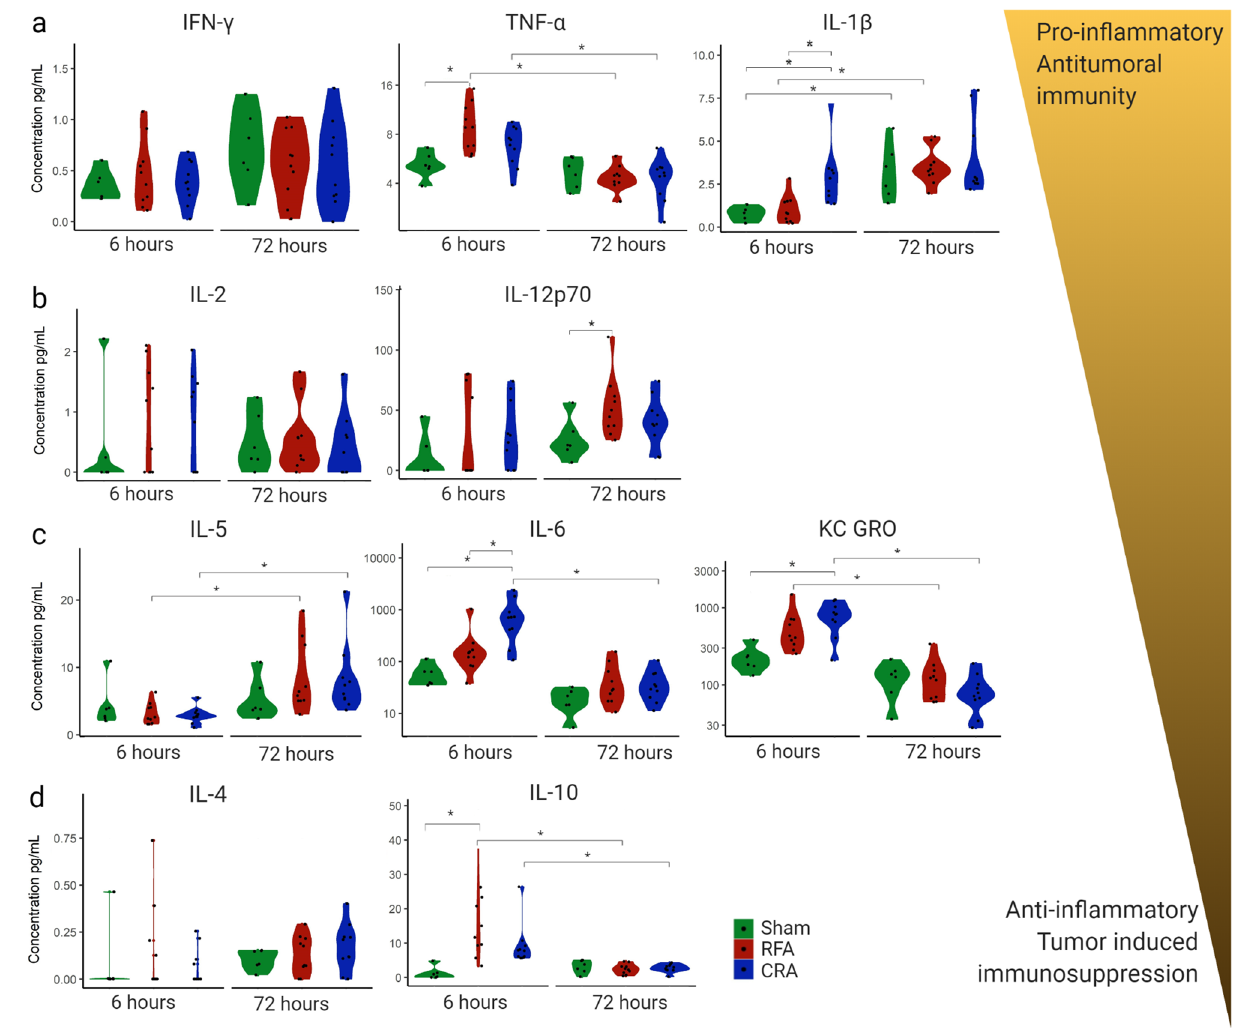
Figure 4. Cytokine secretion 6 and 72 h post ablation. Cytokine secretion in the serum of mice post treatment with sham, RFA, or CRA was measured at 6 h and 72 h post ablation. Cytokines associated with more anti-tumoral response are represented on the top while cytokine with more immunosuppression effects are represented at the bottom. From top to bottom, the secretion of the following cytokines is presented: ( a ) IFN- Ꝩ , TNF-α, and IL-1β, ( b ) IL-2, and IL-12, ( c ) IL-5, IL-6, and KC-GRO, ( d ) IL-4, and IL-10. Repeated- measures model was used to account for the correlation between cytokines level within the same animal